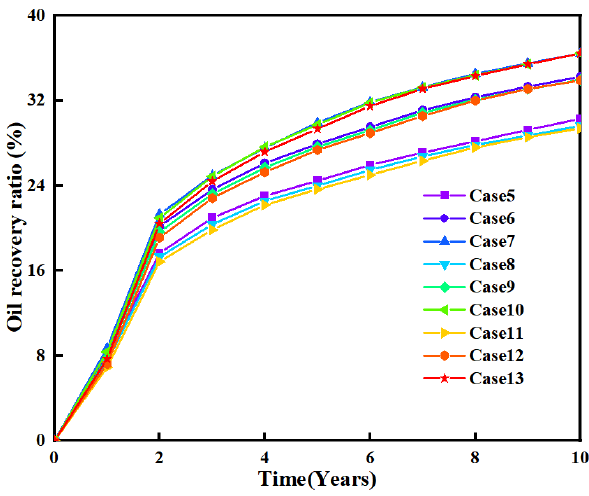
Figure 11. Oil recovery curves of each scheme.